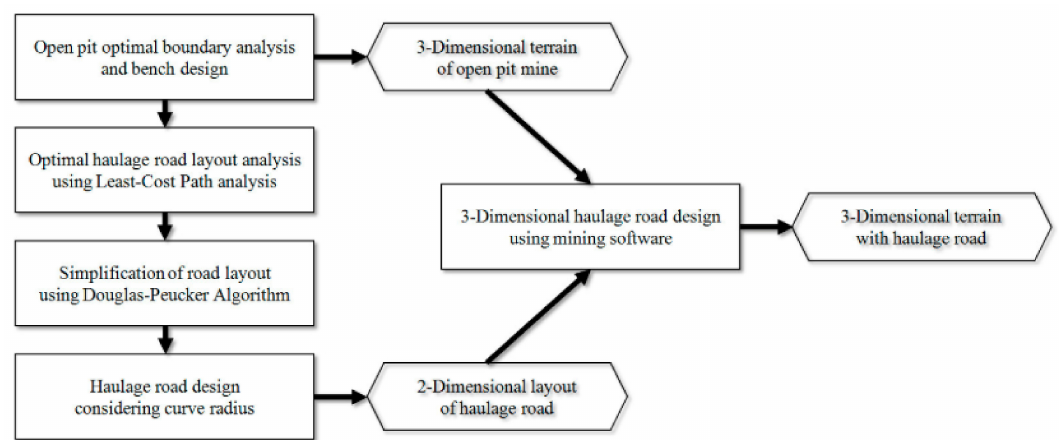
Figure 9. Study process of haul road design for open-pit mines using the proposed method [23].